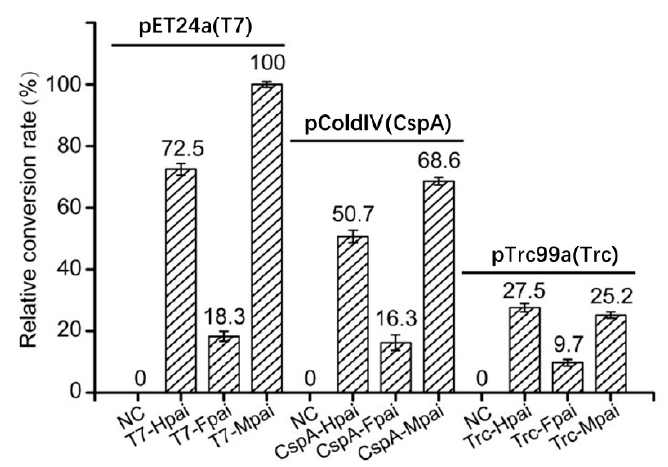
Figure 4. The conversion rate of LA to CLA was catalyzed by different recombinant strains. NC (from left to right): pET24a, pColdIV, pTrc99a. Hpai: His6-PAI, Fpai: Fh8-PAI, Mpai: MBP-PAI.